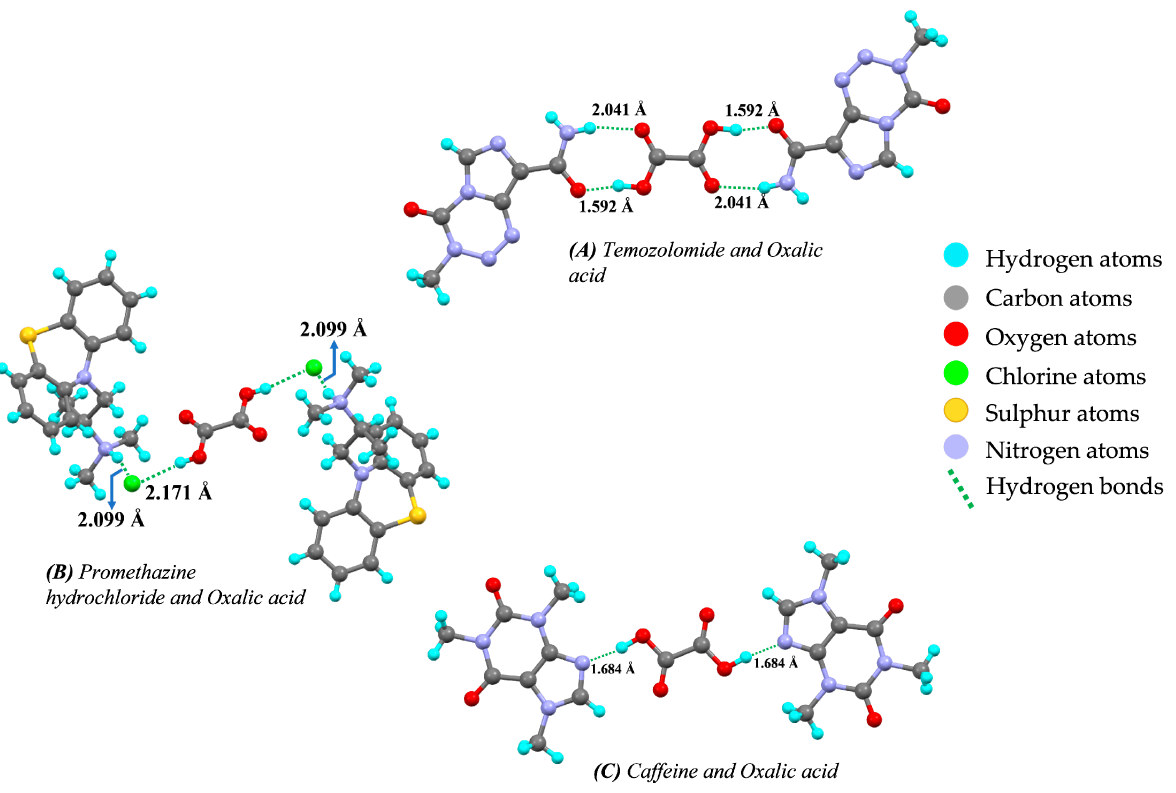
Figure 16. Hydrogen-bond interaction and bond length between drug and coformer represented as ( A ) Temozolomide and oxalic acid (#881197), ( B ) Promethazine hydrochloride and oxalic acid (#1853755), and ( C ) Caffeine and oxalic acid (#272620) (from Mercury 2022.2.0 (Build 353591)). #— CCDC Identifier number.